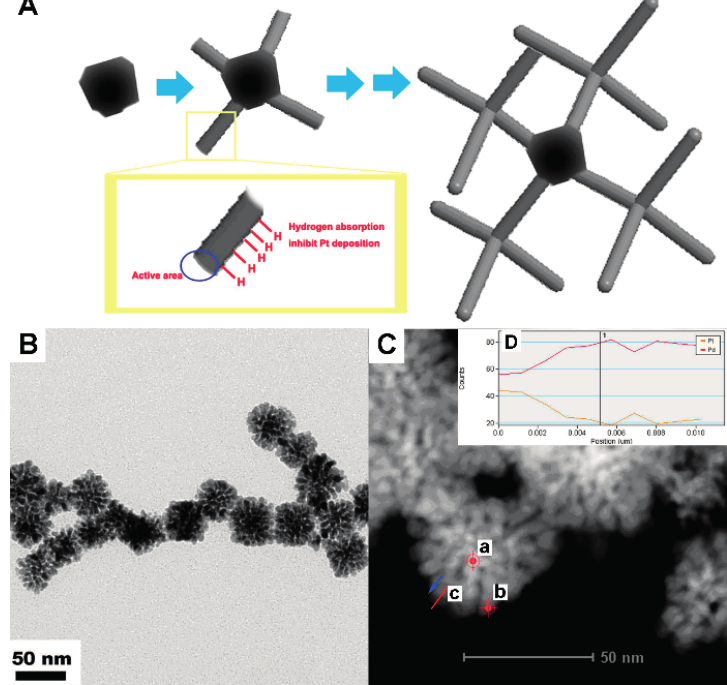
Figure 6. ( A ) The synthetic scheme of Pt/Pd bimetallic nanodendrites; ( B ) The TEM image of Pt/Pd bimetallic nanodendrites; ( C ) The STEM image of Pt/Pd bimetallic nanodendrites as catalysts; ( D ) The line spectrum of c. spot a: both Pt and Pd elements, spot b: only Pd element)